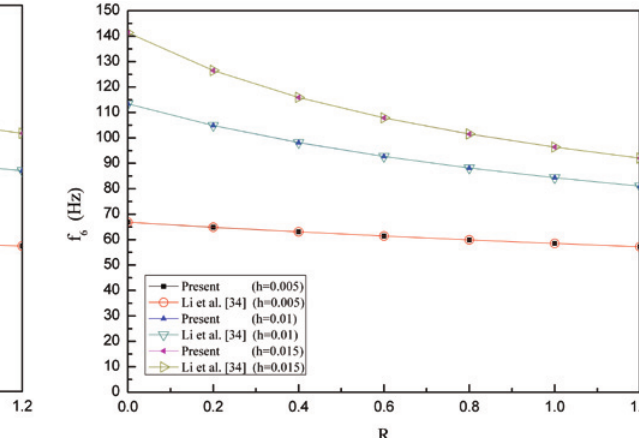
Figure 9 The sixth-order frequency of the clamped square compos- ite laminates with uniform bonding